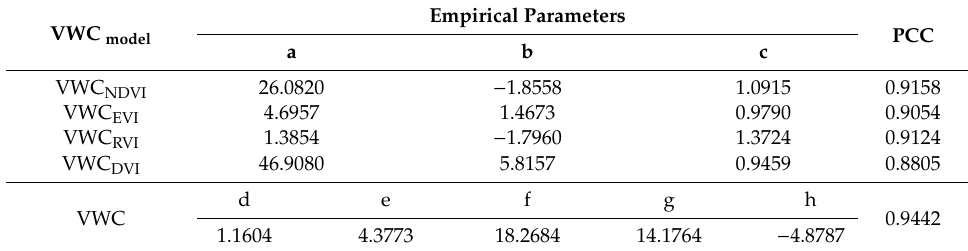
Table 3. Parameters of the VWC model and the PCC based on the 19 validation sample